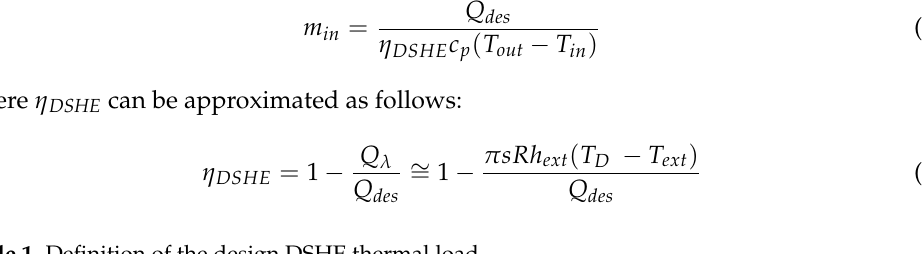
Table 1. Definition of the design DSHE thermal